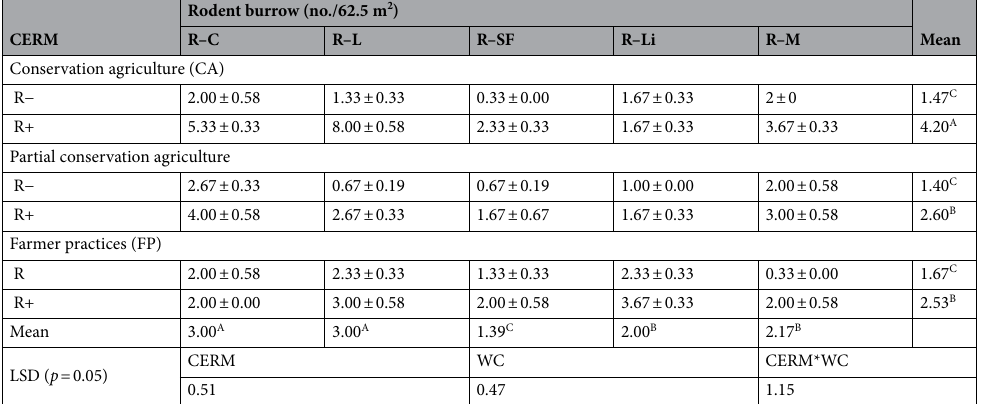
Table 3. Burrows of bandicoot rats, B. bengalensis as influenced by different crop establishment-cum- residue management (CERM) and winter crops in rice-fallow system of eastern India (after 4th years